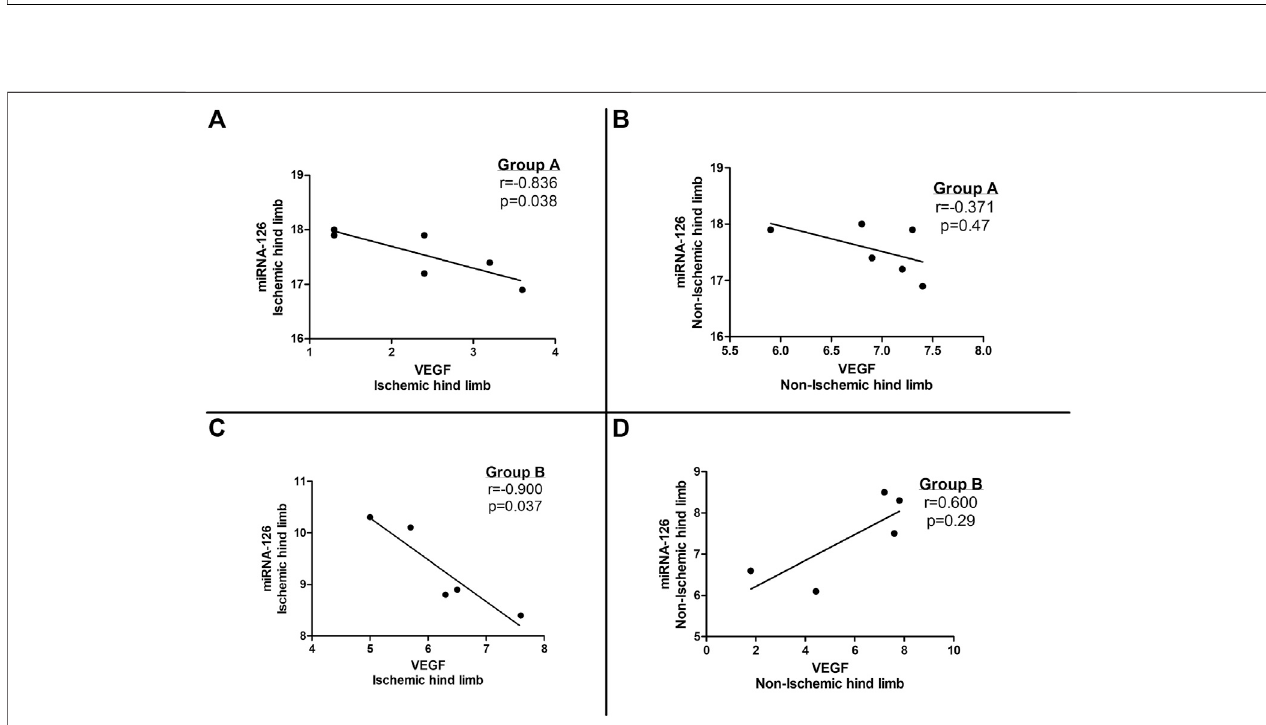
FIGURE 3 | Correlation between tissue vascular endothelial growth factor (VEGF) and microRNA-126 expression in (A) the ischemic hind limb and (B) the non- ischemic hind limb of microRNA-126 treated mice (Group A) as well as in (C) the ischemic hind limb and (D) the non-ischemic hind limb of the control group (Group B).